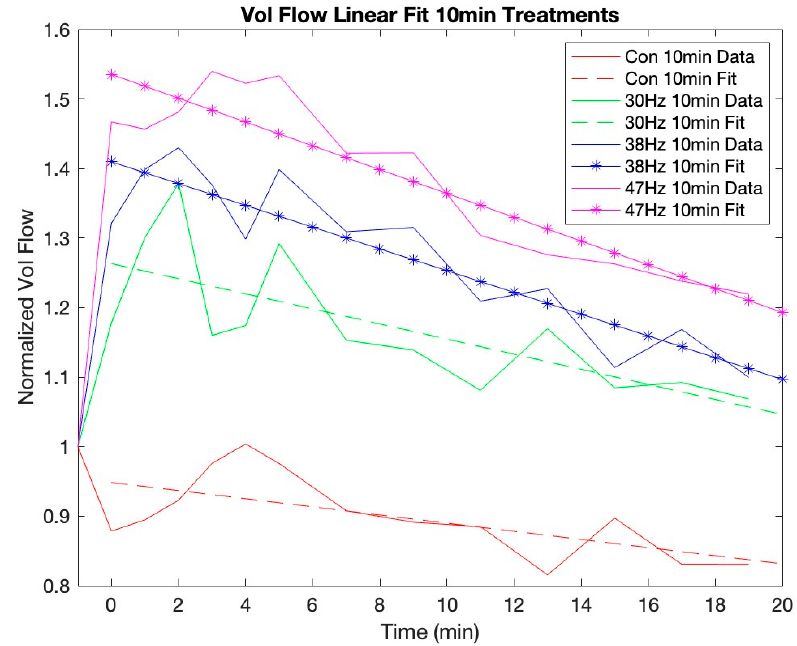
Figure 5. Linear recovery for volume flow with 10-min conditions. Note: 38 Hz and 47 Hz 10 min fit have statistical significance of linear data fit for post-vibrations.